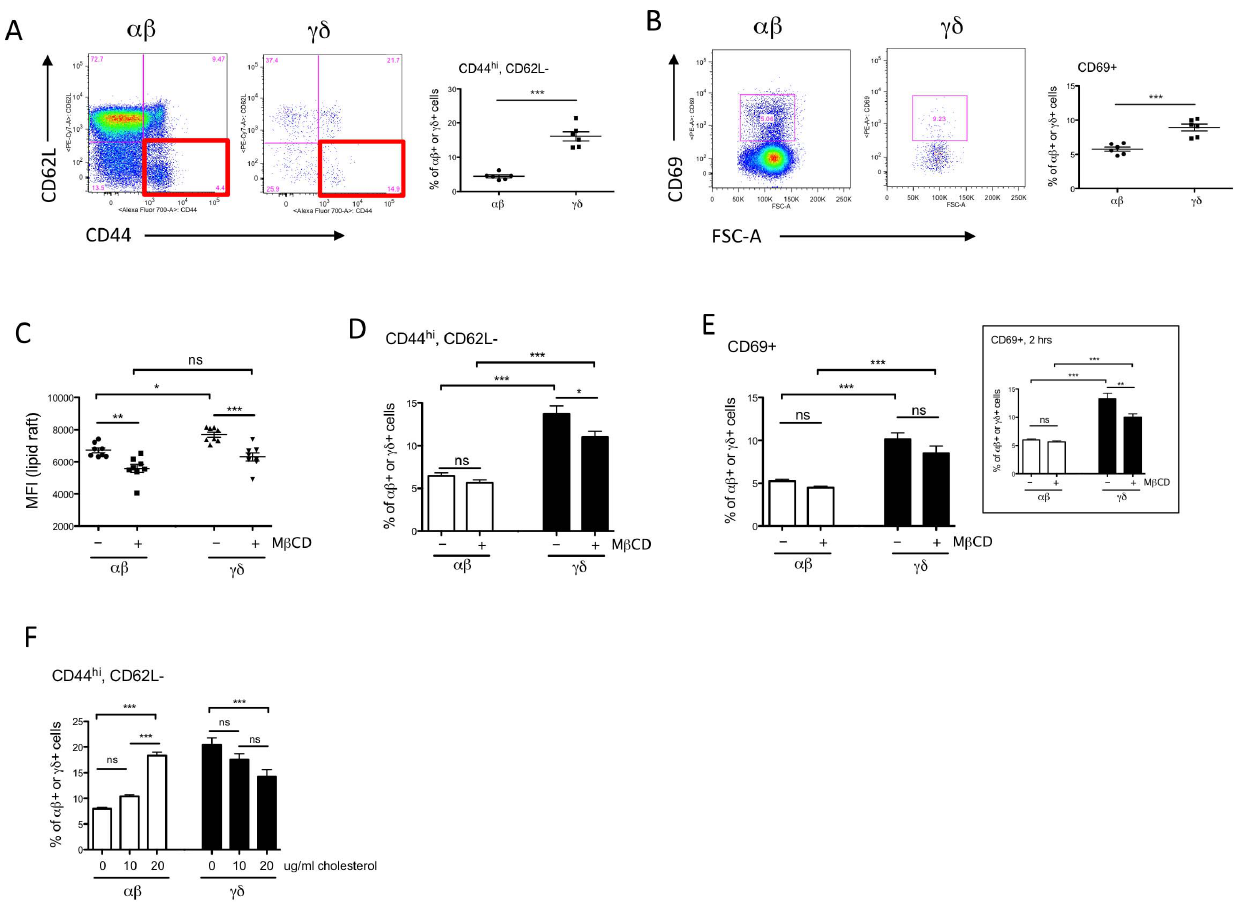
Figure 3. cd T cells are more activated invivo . Cholesterol depletion reduces the activated phenotype of cd T cells. Cholesterol addition significantly increases the activation status of ab T cells. (A–B) Staining of T cell activation markers shows more cd T cell are in the activated state in vivo , comparing to ab T cells. Splenocytes were isolated from C57BL/6J mice. T cell activation was identified by (A) CD44 hi CD62L 2 and (B) CD69 + cells. Representative flow cytometric plots are shown on the left and the percentages of activated T cells are graphed on the right. Results were averaged from 6 mice, and shown in mean 6 SEM. (C–E) Splenocytes from C57BL/6J were stimulated with T-activator CD3/CD28 beads for 4 hours in the presence or absence of M b CD to remove cholesterol from the plasma membrane. (C) Reduction of lipid raft levels in ab and cd T cells with cholesterol depletion. The reduction was more significant in cd T cells, and the difference in lipid raft level became insignificant in ab and cd T cells after M b CD treatment. Lipid raft content was expressed in median florescent intensity of CT-B staining. (D) The percentage of CD44 hi CD62L 2 cells was significantly lower in cd T cells after 4 hours of cholesterol depletion. (E) The difference in expression of early activation marker CD69 was not statistically significant in both ab or cd T cells after M b CD treatment for 4 hours. However, the reduction of CD69 was significant in cd T cells at 2 hours (inset) Results were averaged from 8 mice. Results were shown in mean 6 SEM. (F) C57BL/6J splenocytes were stimulated with T-activator CD3/CD28 beads in the presence or absence of 10 and 20 m g/ml cholesterol for 4 hours. The percentage of CD44 hi CD62L 2 cells was significantly increased in ab T cells in a dose-dependent manner of cholesterol addition. On the other hand, activated cd T cells were reduced with excess cholesterol. Results were averaged from 8 mice and shown in mean 6 SEM. * P , 0.05; ** P , 0.01; *** P , 0.001; ns not statistically